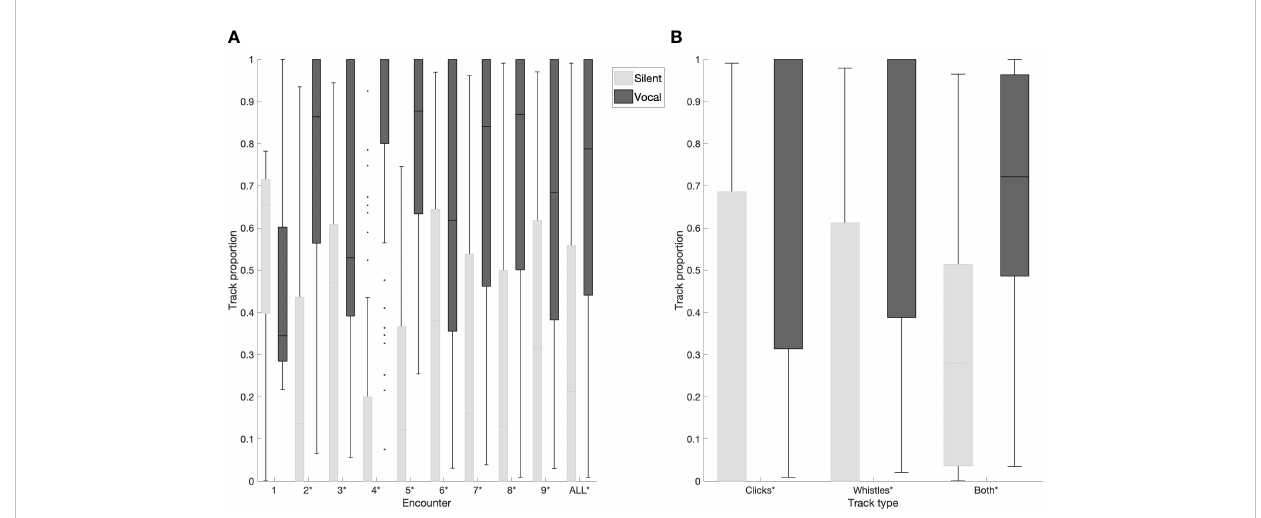
FIGURE 3 Track proportion spent in a given state, vocal or silent, (A) for each encounter and for all encounters collectively, (B) for each track type collectively. On each box the central line indicates the median, the bottom and top edges of the box indicate 25th and 75th percentiles, respectively. The whiskers extend to most extreme data points not considered outliers, and outliers are indicated as black dots. Statistically signi fi cant results are denoted with an asterisk.